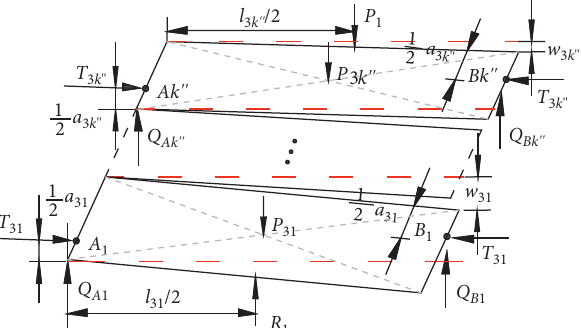
Figure 12: The force characteristic of hinged roof